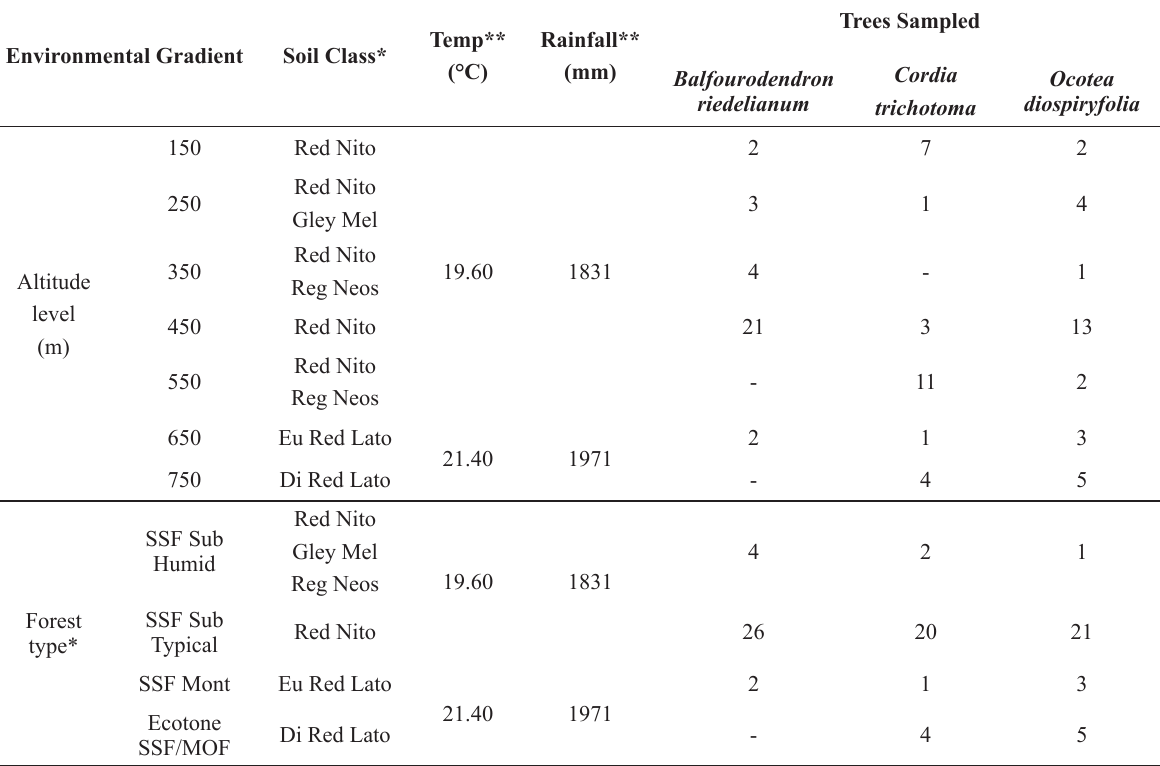
Trees sampled at altitude levels and forest types with respective environmental characteristics in the Iguaçu National Park